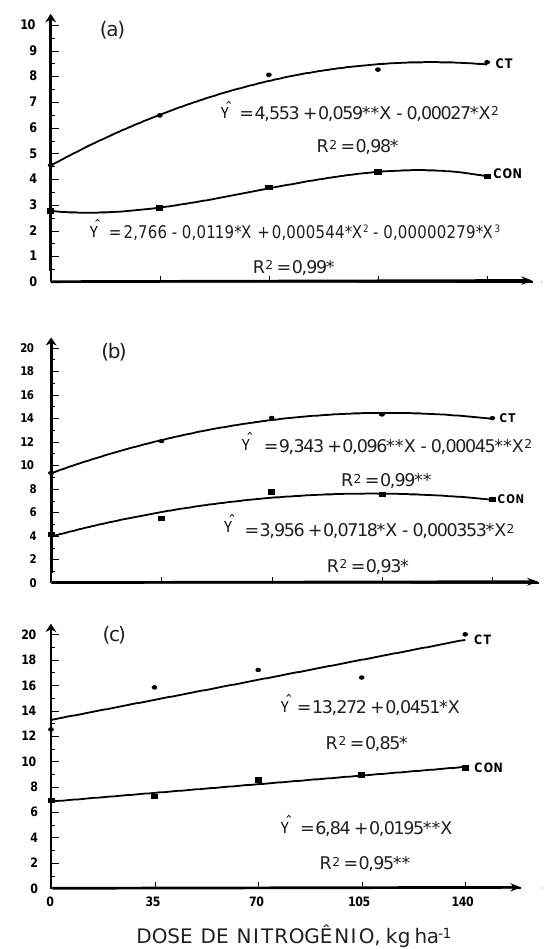
Figura 2 . Produção de matéria seca total (parte aérea+bulbo+raízes) de plantas de alho provenientes de cultura de tecidos (CT) e multiplicação convencional (CON), 90 (a), 110 (b) e 130 (c) dias após o plantio, considerando as doses de nitrogênio. *, ** significativos a 5 e 1%, respectivamente, pelo teste